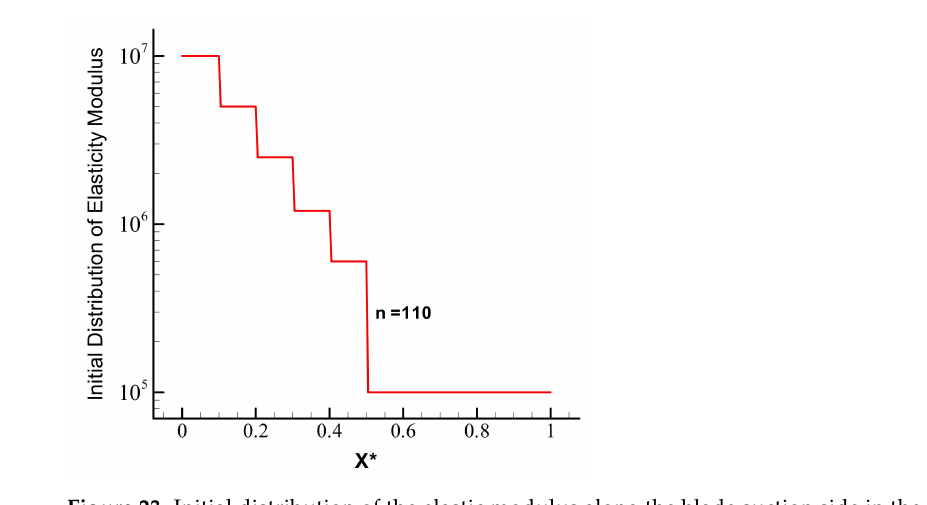
Table 4. CPU times, number of shape modifications and the convergence residuals for the design cases.